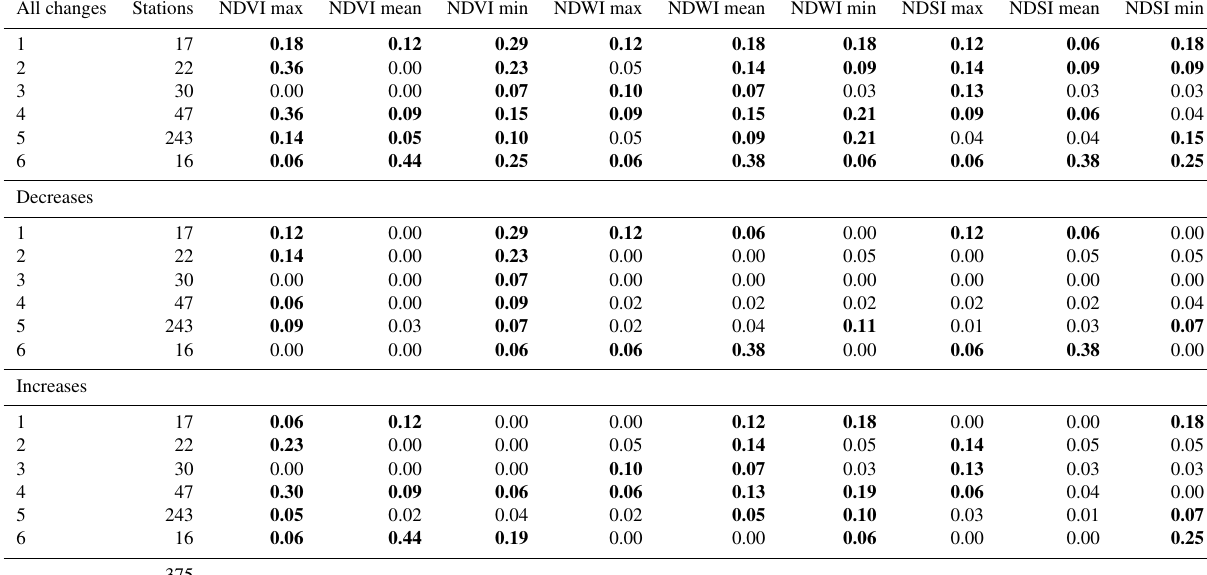
Table 8. Changes in satellite indices by Trend Pattern. The numbers are the fraction of stations showing a trend; values greater than 0.05 are in